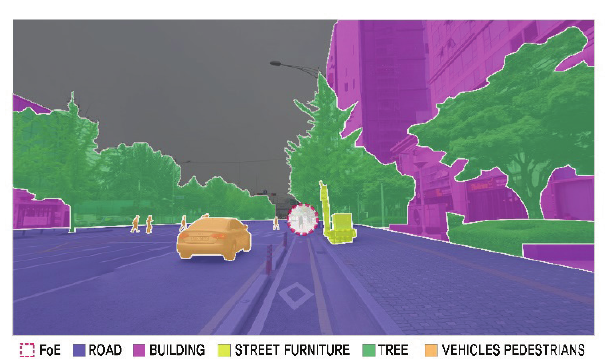
Figure 3. Classification of road